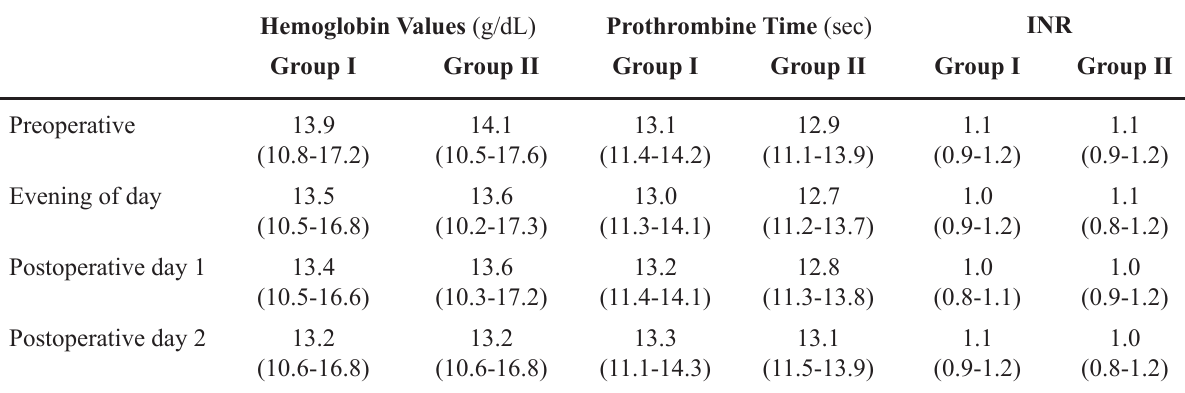
Table 2 – Hemostatic parameters for the 2 groups. No significant differences in any parameters (p >